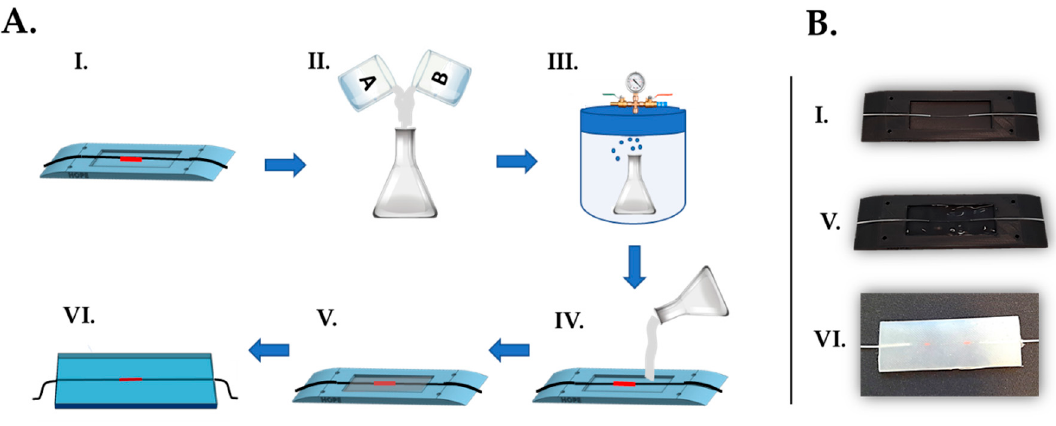
Figure 1. Manufacturing process of the flexible FBG-based sensing element. ( A ): Schematic of the fabrication steps; ( B ). Details of the phases I., V. and VI.